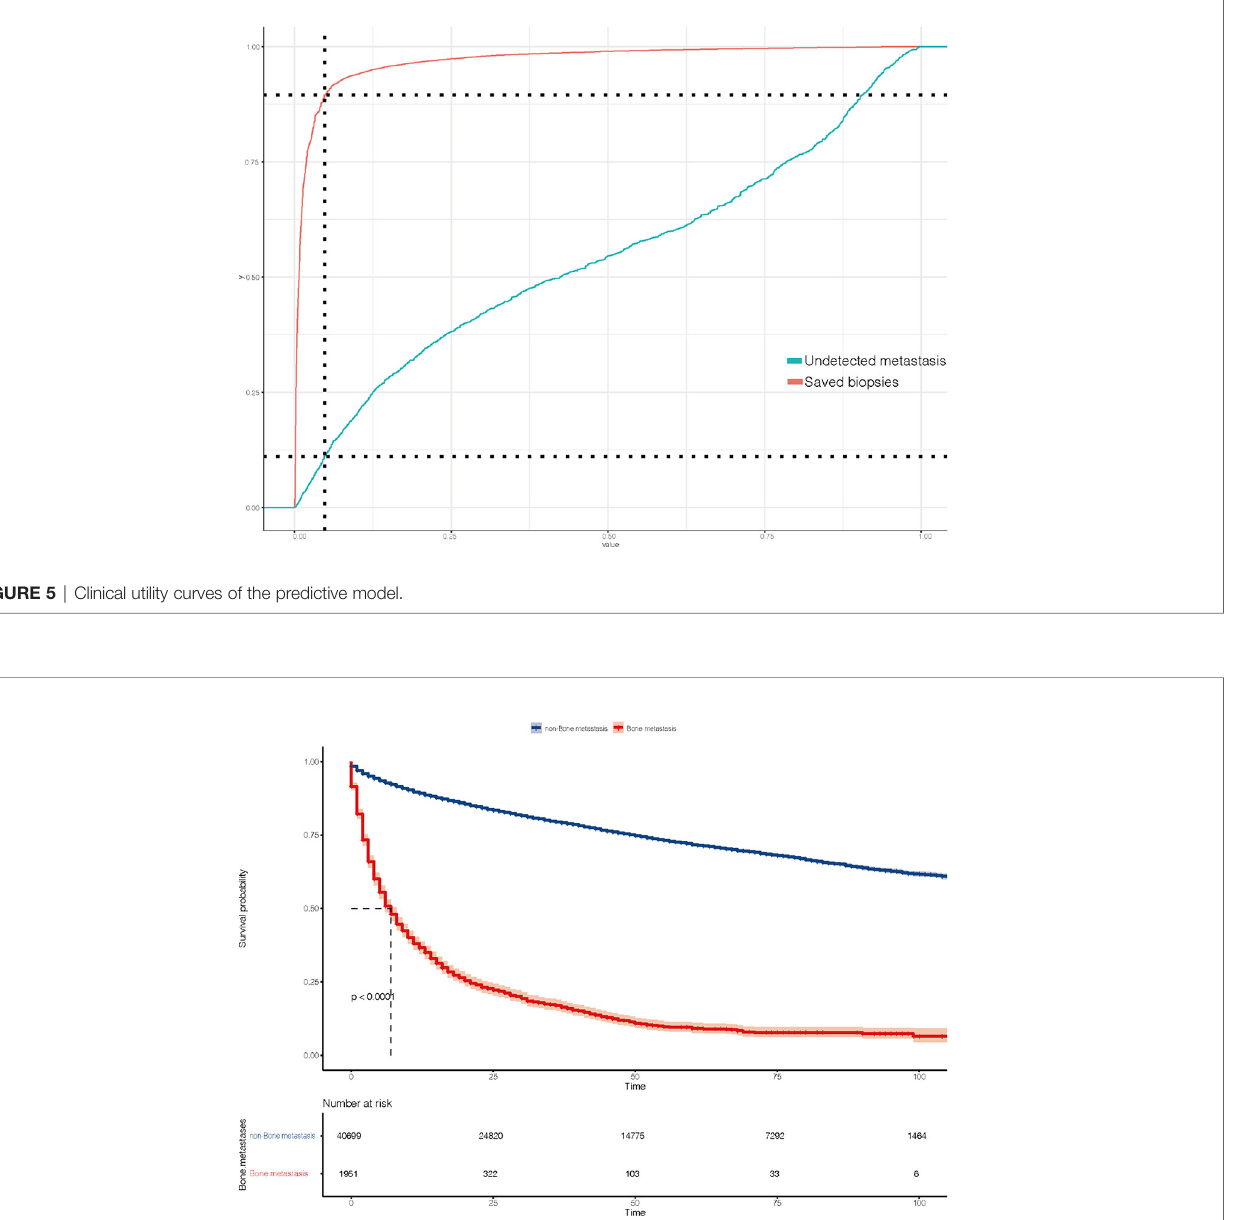
FIGURE 6 | Kaplan-Meier survival curve of bone metastases in patients with kidney